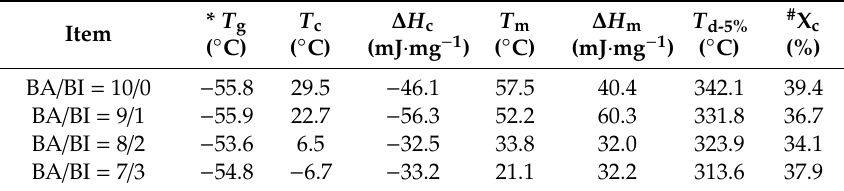
Table 3. Thermal property of the PBABI copolyesters.